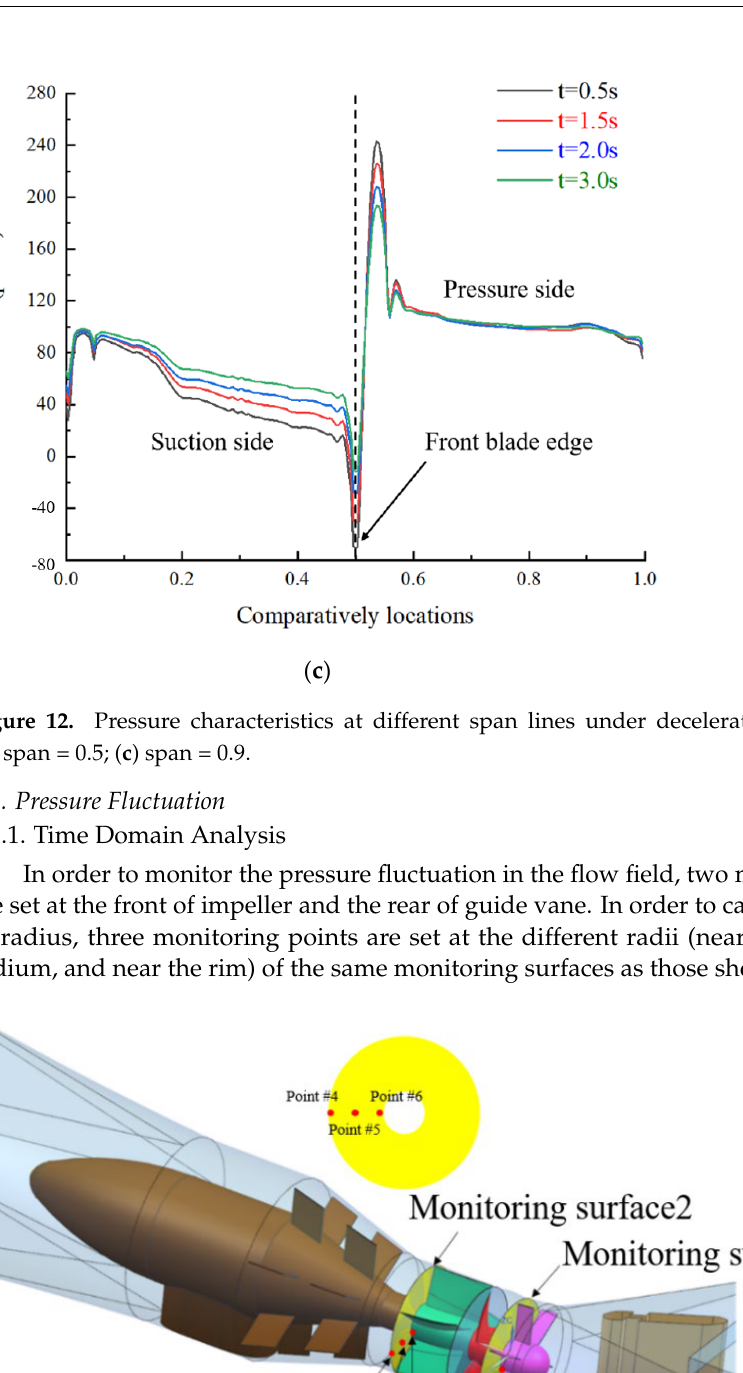
Figure 13. Pressure fluctuation monitoring points.